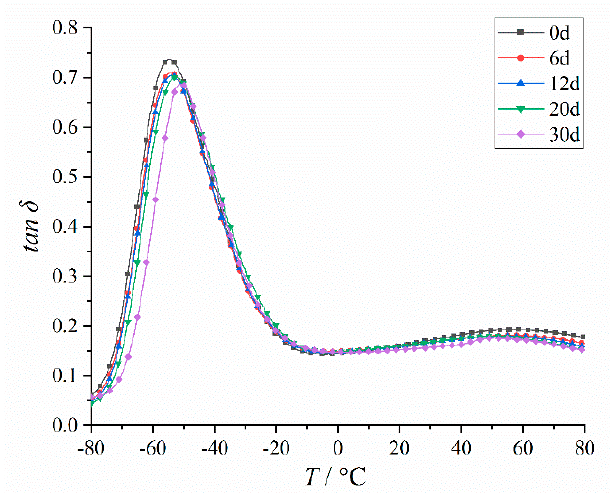
Figure 5. Changing curves of tan δ of the HTPB coating at different aging times.